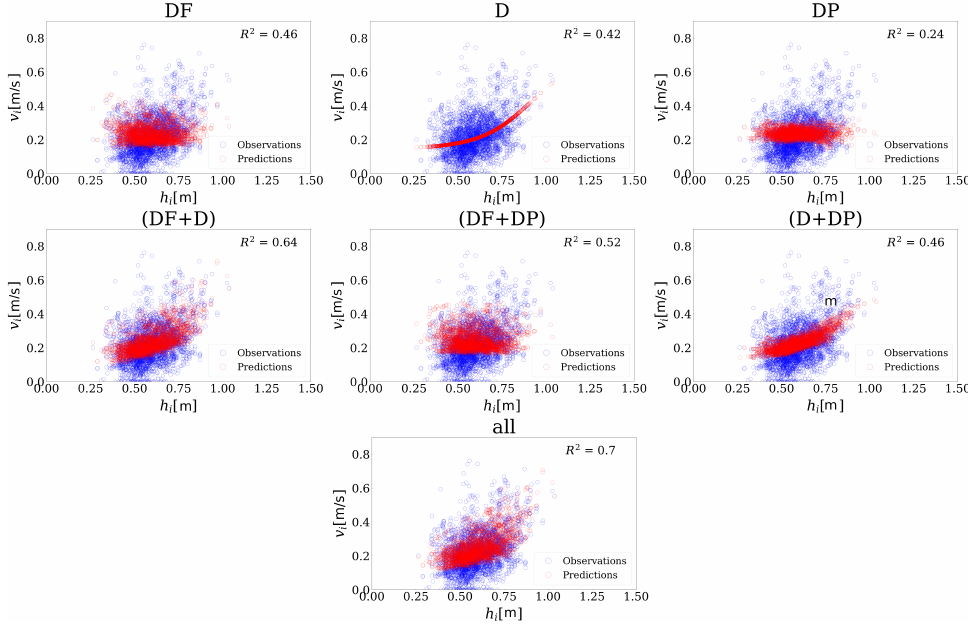
Figure 8. Examples of speed predictions from testing the neural networks ( D , DF , ( DF + D ), ( DF + DP ), ( DP + D ), ( all )) using UX, N = 20, 24, 30 samples. As observed in the actual data (in blue), the speed values for given headway distances tend to be close to the observed values when we combine DF and D as inputs to the FFNN algorithm or when we have more input features ( all ) . The R 2 values on the top-right of the figure are calculated to compare the variability of the estimated